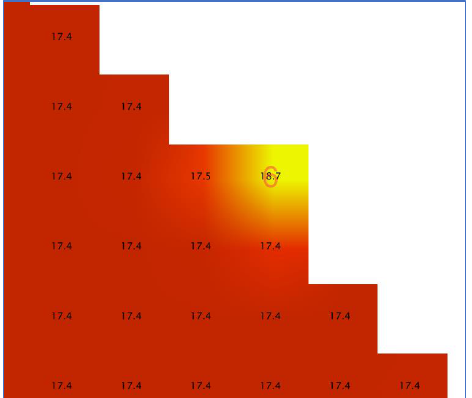
Figure 5. Example of a potential flier detected by the Noisy Edges algorithm (marked with an orange 6). The black values are depth values in meters from the evaluated grid; the sub-index represents decimeters. The algorithm crawls across empty cells to establish the edge nodes. Once an edge node is identified, the least depth and the maximum difference from its neighbors are calculated. The least depth is used to calculate to local Total Vertical Uncertainty, which is used for the flagging threshold